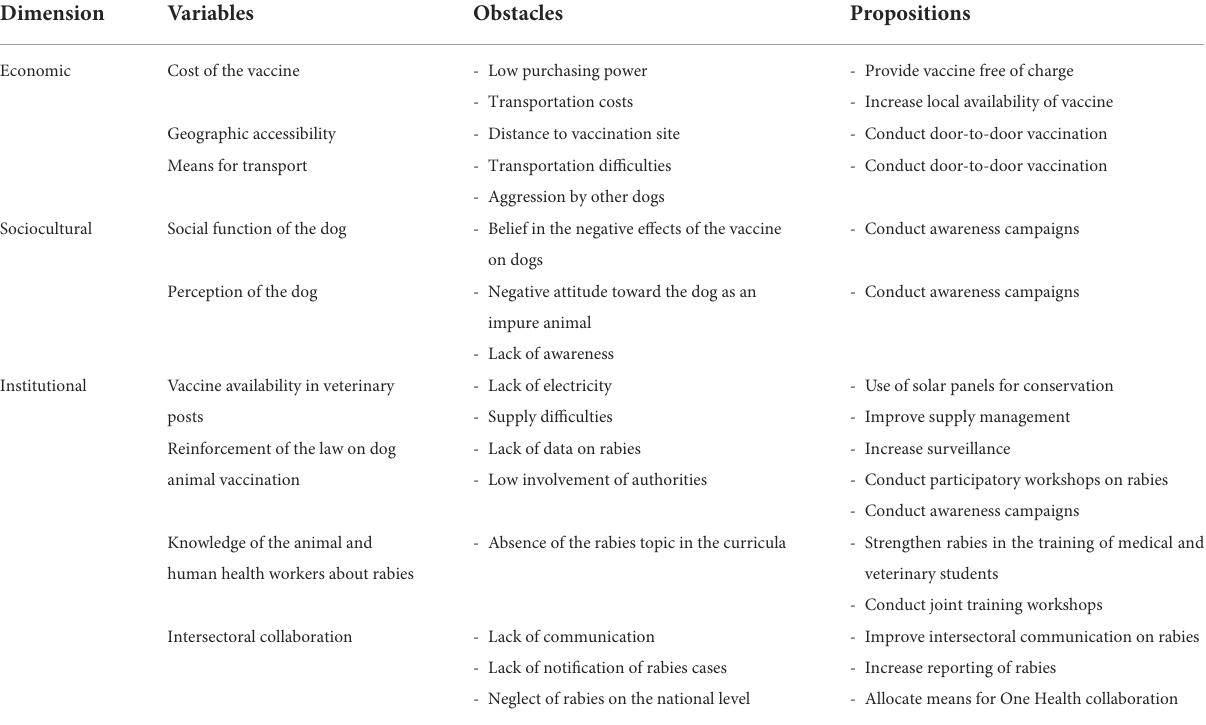
TABLE 2 Summary of factors influencing access to dog vaccination in Chad.